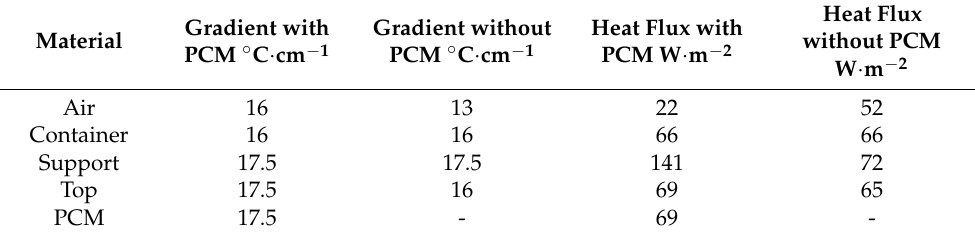
Table 7. Maximum thermal gradients and heat flux of the